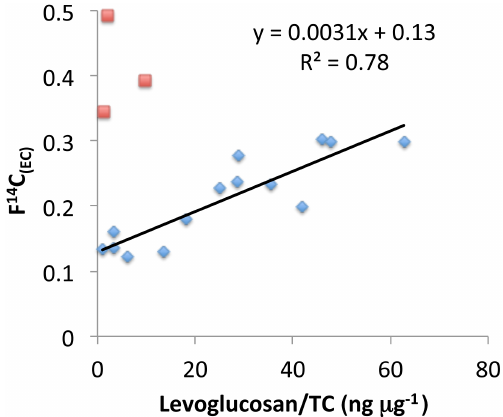
Figure 2. F 14 C ( EC ) vs. levoglucosan mass fraction in the carbona- ceous aerosol. The data marked in red are from three periods in spring 2011, when high pollen concentrations were measured. The F 14 C data are not corrected for charring bias. The regression line and regression equation corresponds to a linear LS fit to the blue data